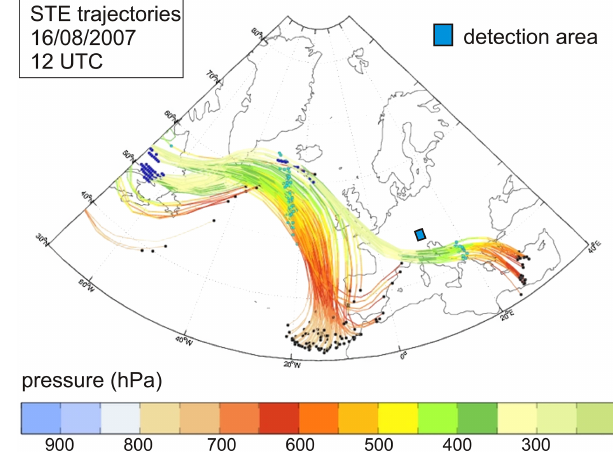
Figure 8. STE trajectories calculated with the tool of ETH Zürich, based on ECMWF data. The trajectories were initiated on 16 Au- gust 2007 at t 0 = 12:00UTC. The time positions on the trajectories for t 0 , t 0 + 2d and t 0 + 4d are marked by azure, cyan, and black dots, respectively.The frame of the detection area (2 ◦ × 2 ◦ ) around Garmisch is marked by the blue